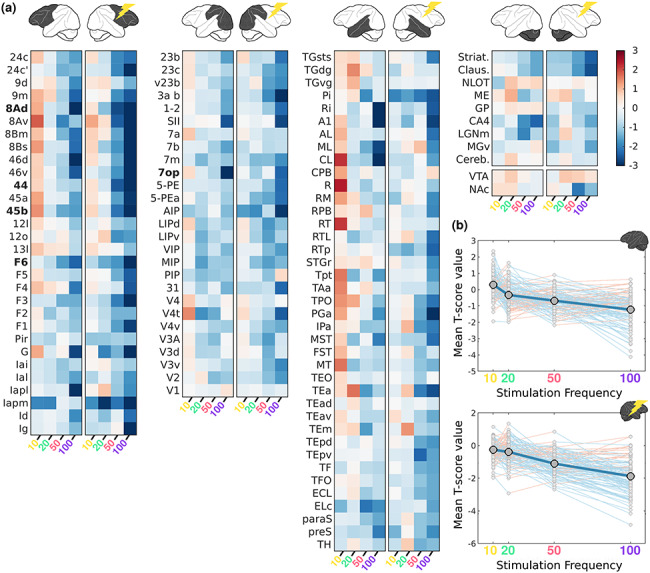
ROI analysis of VTA stimulation-induced activity as function of frequency in sedated monkeys. (a) Heat maps of activity (mean t-score values) for ROIs in the left and right hemispheres as function of stimulation frequency. (b) Mean t-score values (gray circles) for anatomical ROIs combined for the left, unstimulated, (top) and right, stimulated, hemispheres (bottom). Connecting lines between each of the ROIs point to an increase (pink) or decrease (light blue) in activity between neighboring stimulation frequencies. Conventions as in Figure 5.